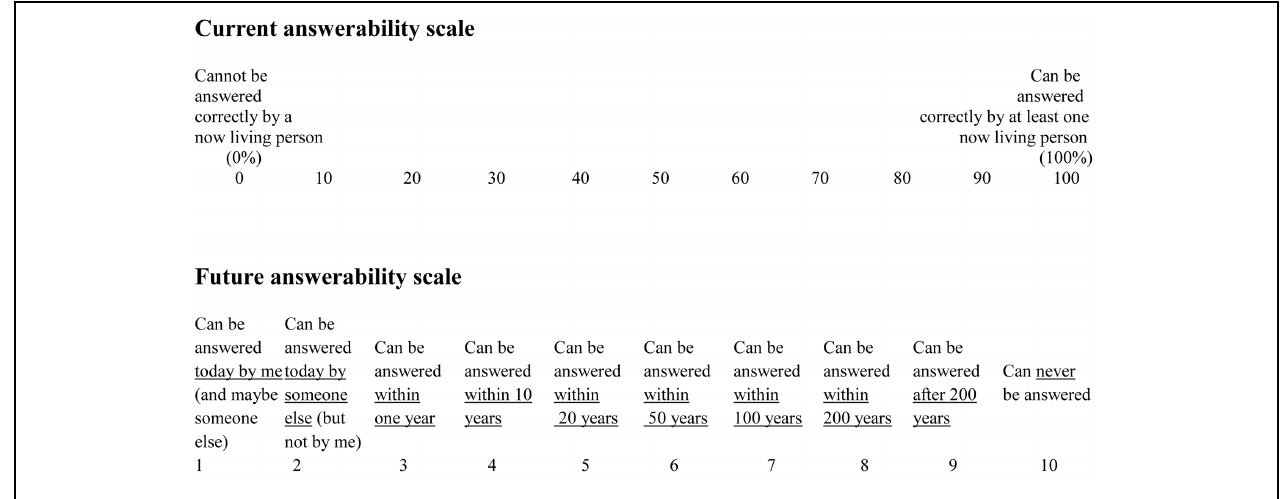
FIGURE 1 | The current answerability scale and the future answerability scale.